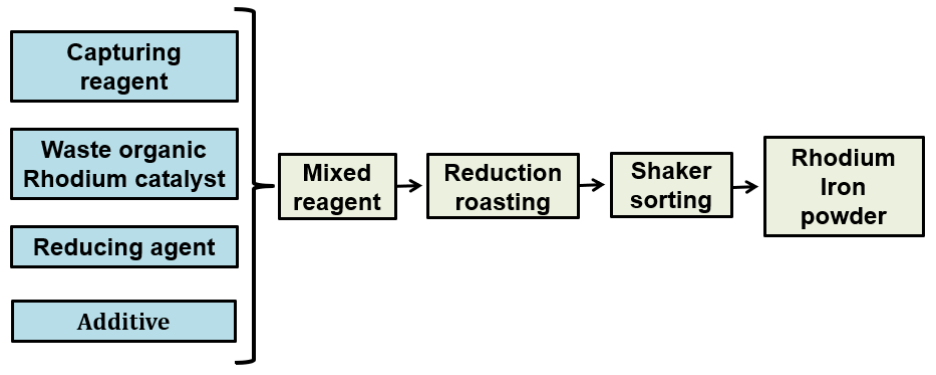
Figure 4. Flow chart for Rh recovery via metal capture.